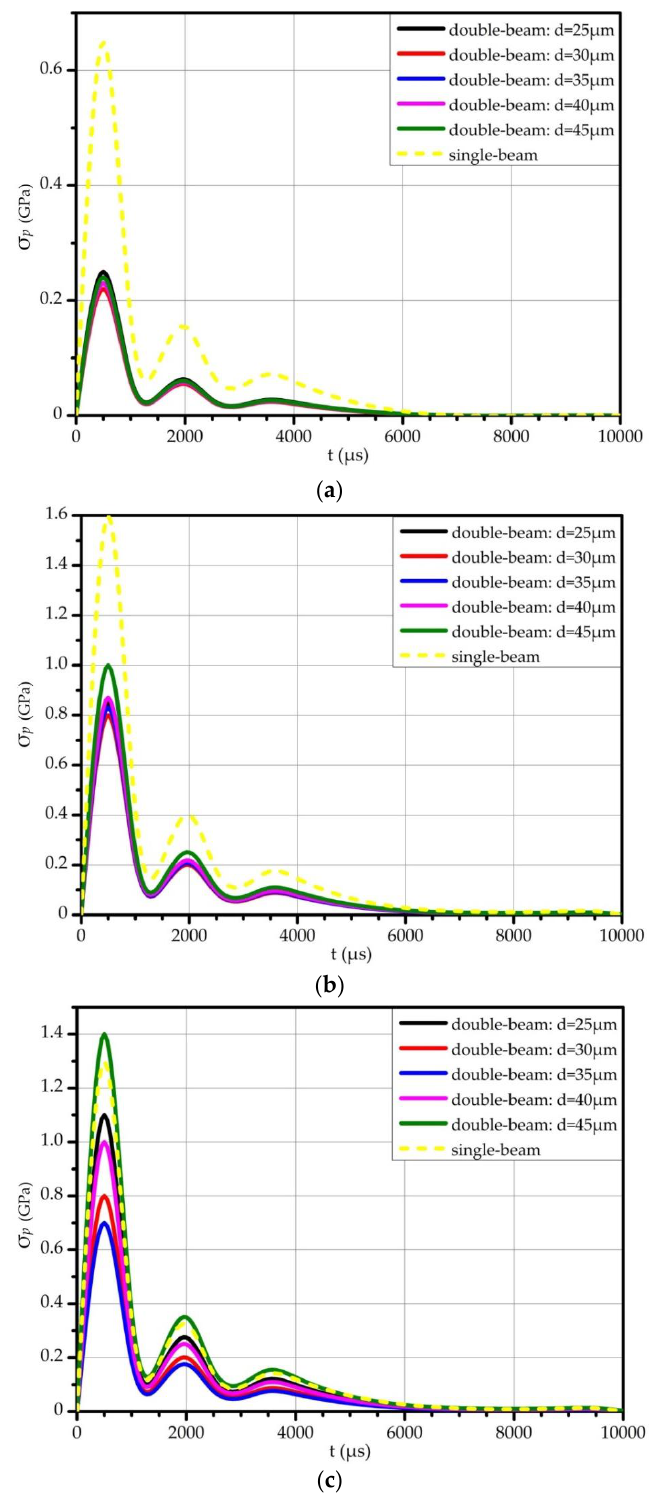
Figure 8. Time evolution of the maximum principal stress in critical regions of double-beam torsional accelerometer and single-beam torsional accelerometer when the high-g acceleration is applied along all three axes in trend line: ( a ) Simulation results when the high-g acceleration is applied along x -axis; ( b ) Simulation results when the high-g acceleration is applied along y -axis; ( c ) Simulation results when the high-g acceleration is applied along z -axis.